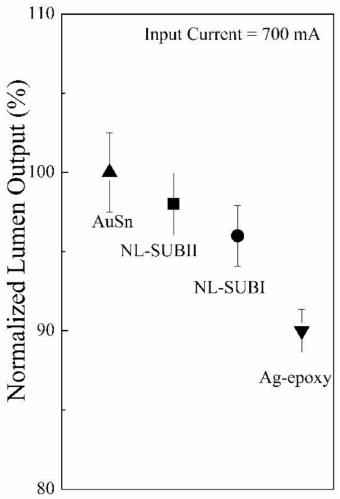
Figure 8. Normalized lumen output of the devices made by the NL bonding method with different substrates and two conventional die–substrate bonding methods at an input current of 700 mA: the solid circle symbol ( • ) represents NL bonding with substrate type-I; the solid square symbol ( (cid:4) ) represents NL bonding with substrate type-II; the solid upside triangle ( (cid:78) ) represents AuSn bonding with an industrial standard BLT value of 20 ± 2 µ m; and the solid downside triangle ( (cid:72) ) represents Ag-epoxy bonding with an industrial standard BLT value of 25 ± 2 µ m.